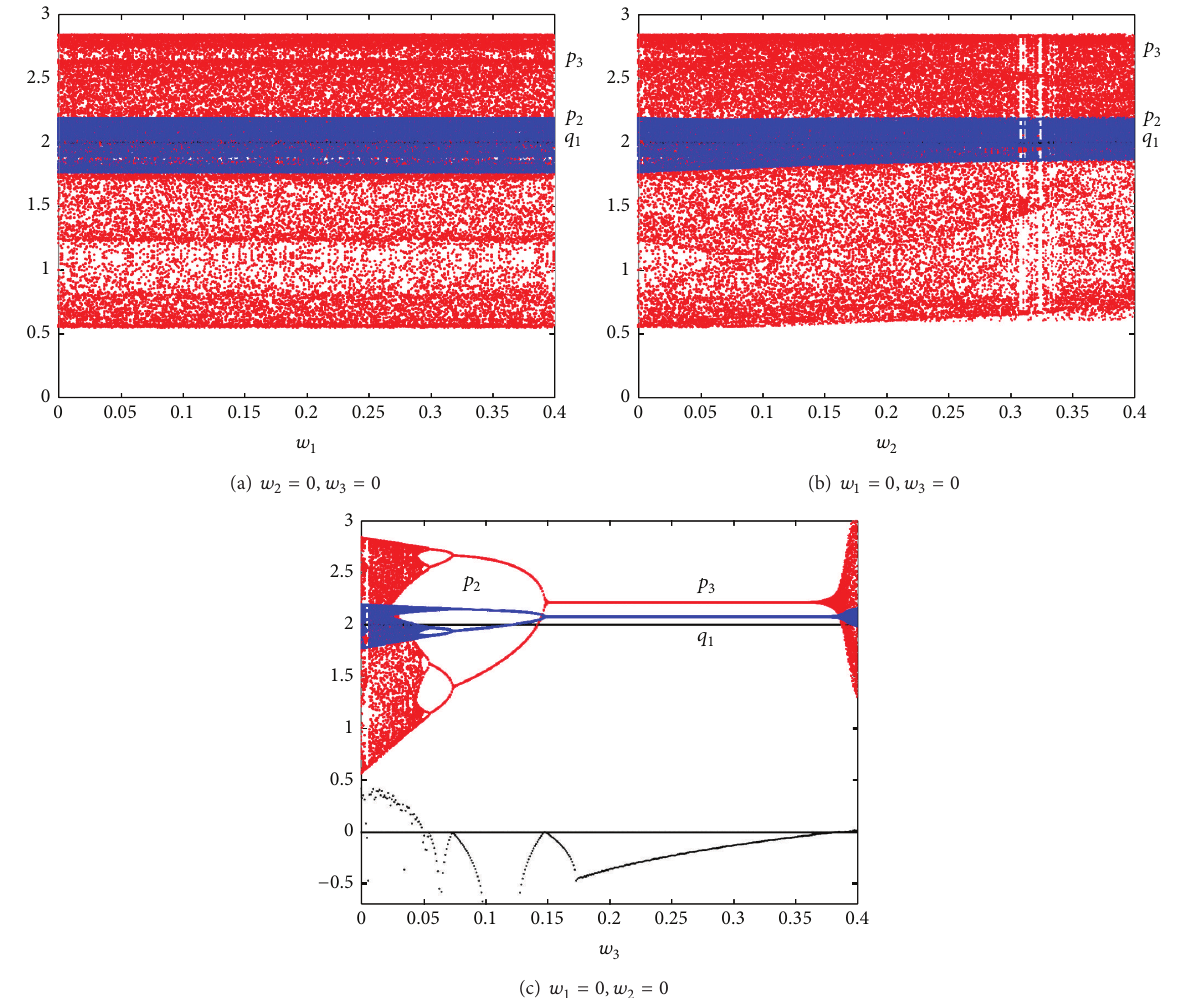
Figure 16: The bifurcation diagram and the corresponding largest Lyapunov exponent of the delayed system